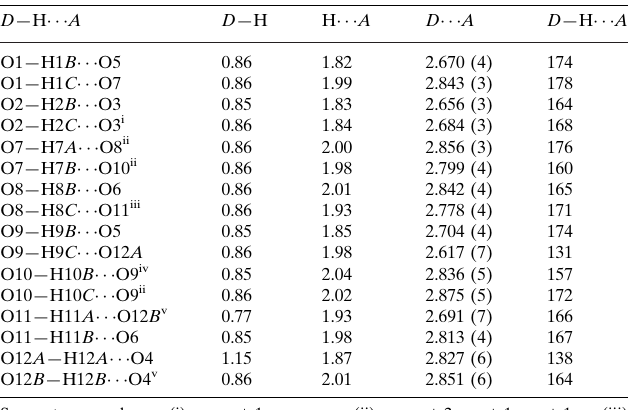
Hydrogen-bond geometry (A˚ , (cid:3)